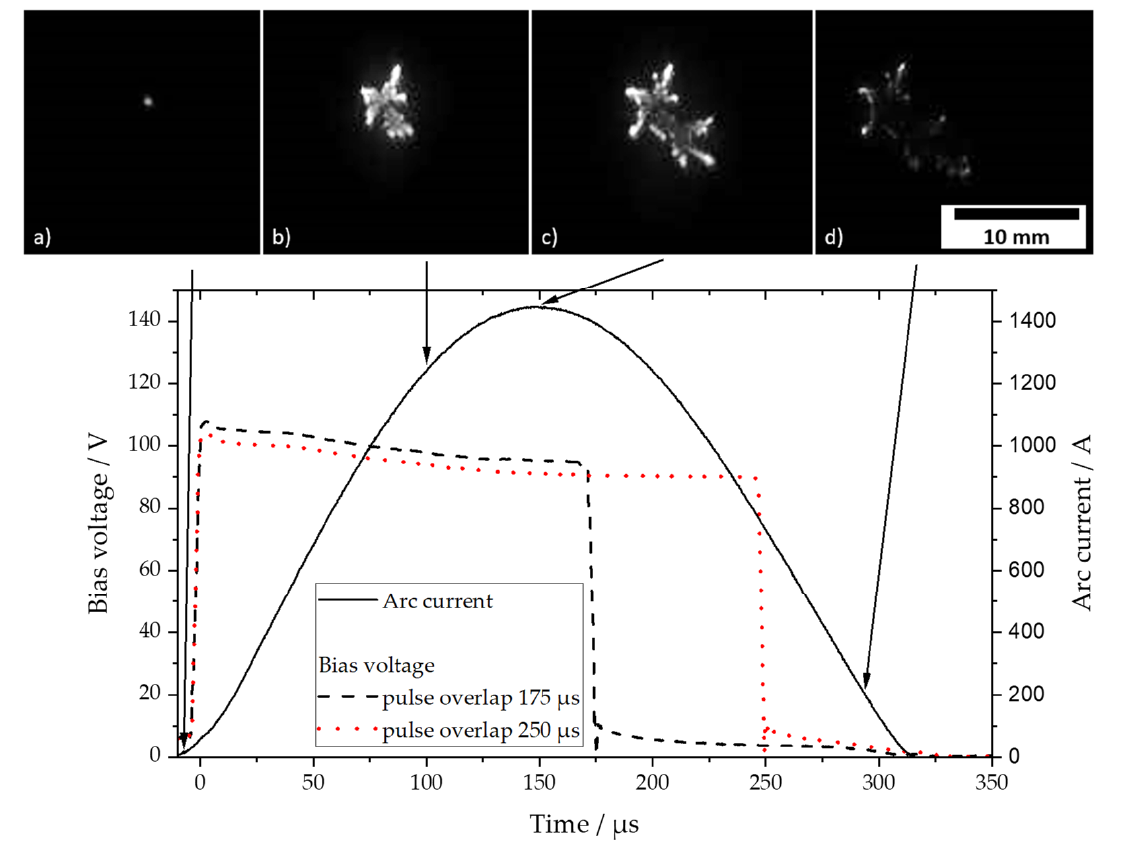
Figure 3. Time-resolved arc current and different bias pulse overlaps and arc-spot images spreading at 1450 A at ( a ) 0 µ s (laser ignition), ( b ) 100 µ s, ( c ) 150 µ s (maximum current), and ( d ) 300 µ s. Table 3. Mean energy of the carbon ions for coatings A, B, and